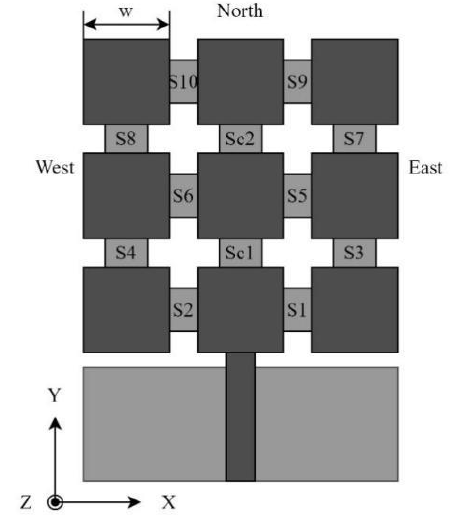
Figure 6. Pixel antenna geometry with the switches.